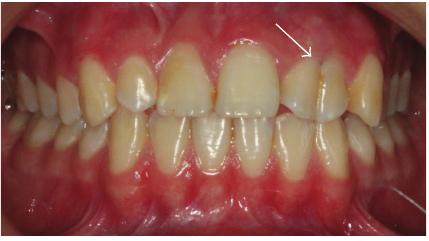
Figure 1: Clinical appearance of fused teeth; labial intraoral view.